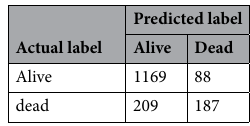
Table 10. Confusion matrix obtained using GLM algorithm according to fGOS.